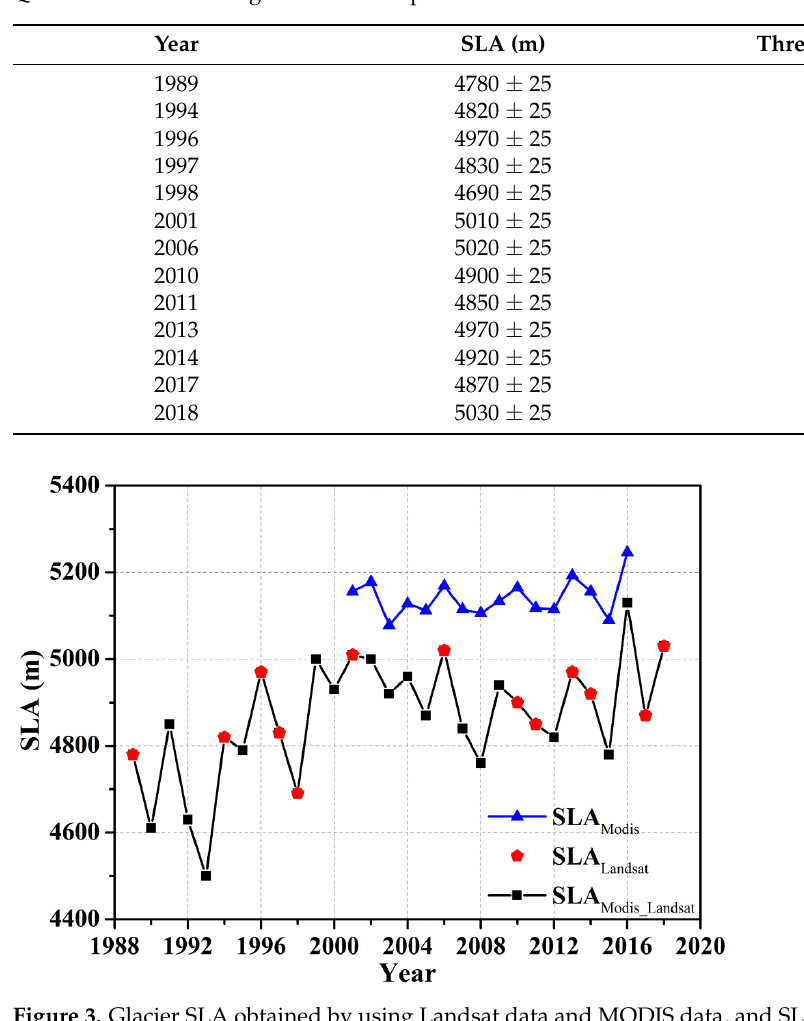
Table 4. Threshold for determining the position of the snow line and SLA of Qiyi Glacier in the Qilian Mountains during the 1989–2018 period.